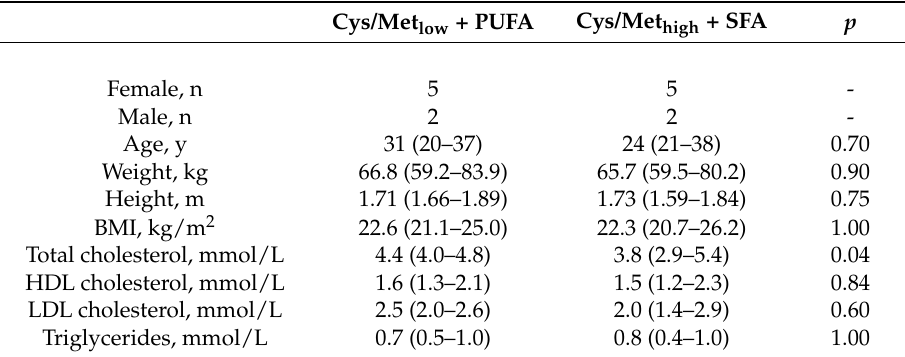
Table 1. Characteristics of the study